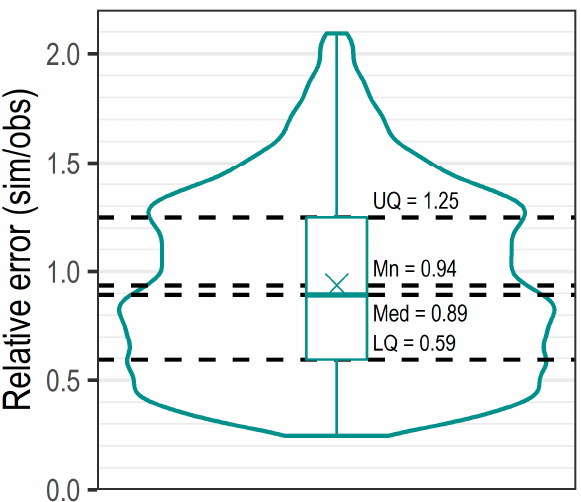
Figure 6. Hydroecological model parameter uncertainty, the distribution of the relative error for 10,000 MC simulations. The box plot illustrates the spread of the data (summary statistics), whilst the violin plot highlights the distribution (or density) of the uncertainty.